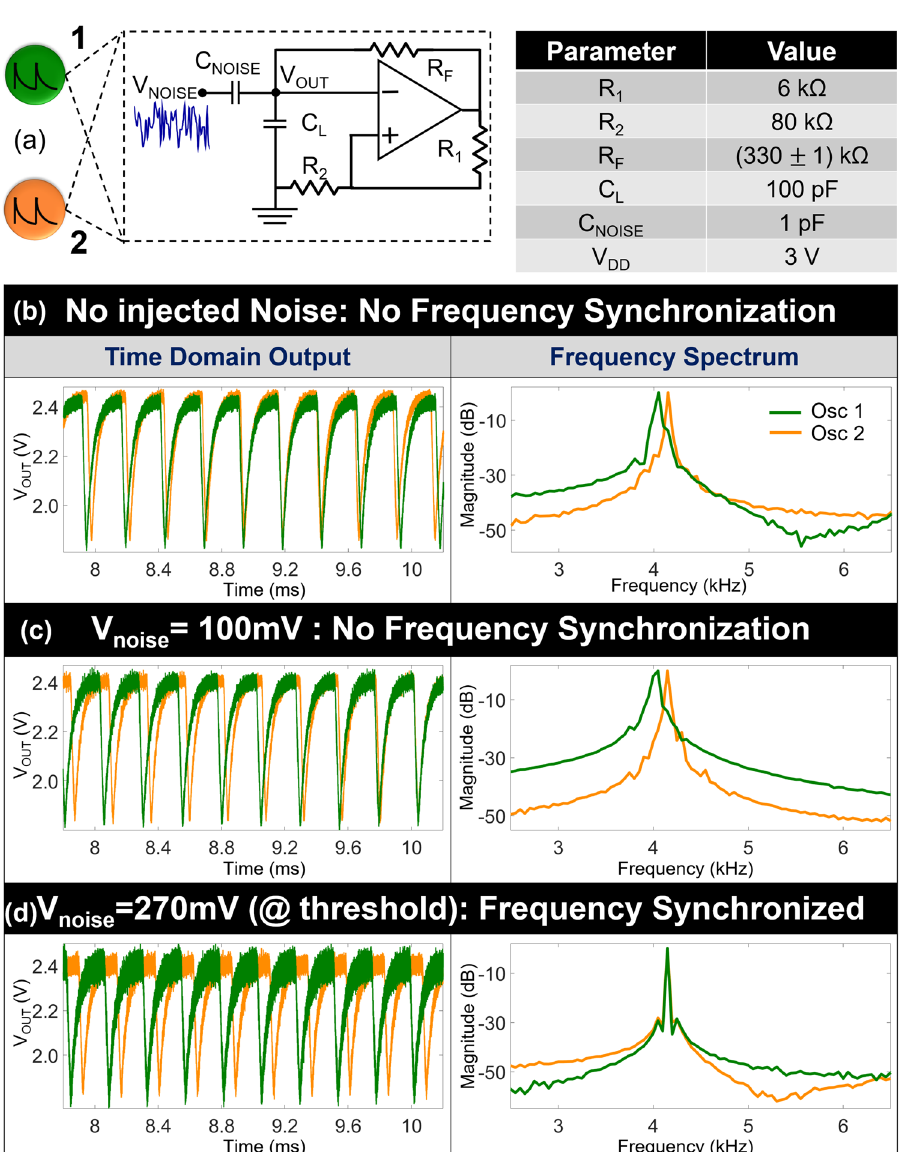
noise inputs: ( b ) No noise; ( c ) V NOISE = 100 mV RMS ; ( d ) V NOISE = 270 mV RMS . No frequency locking is observed until V NOISE ≥ 270 mV RMS